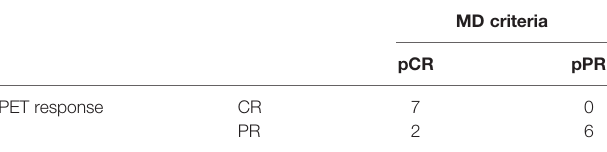
TABLE 2 | Comparison of the results of PET [EORTC (21)] and MD Anderson [RCB pathological response (22, 23)] criteria.